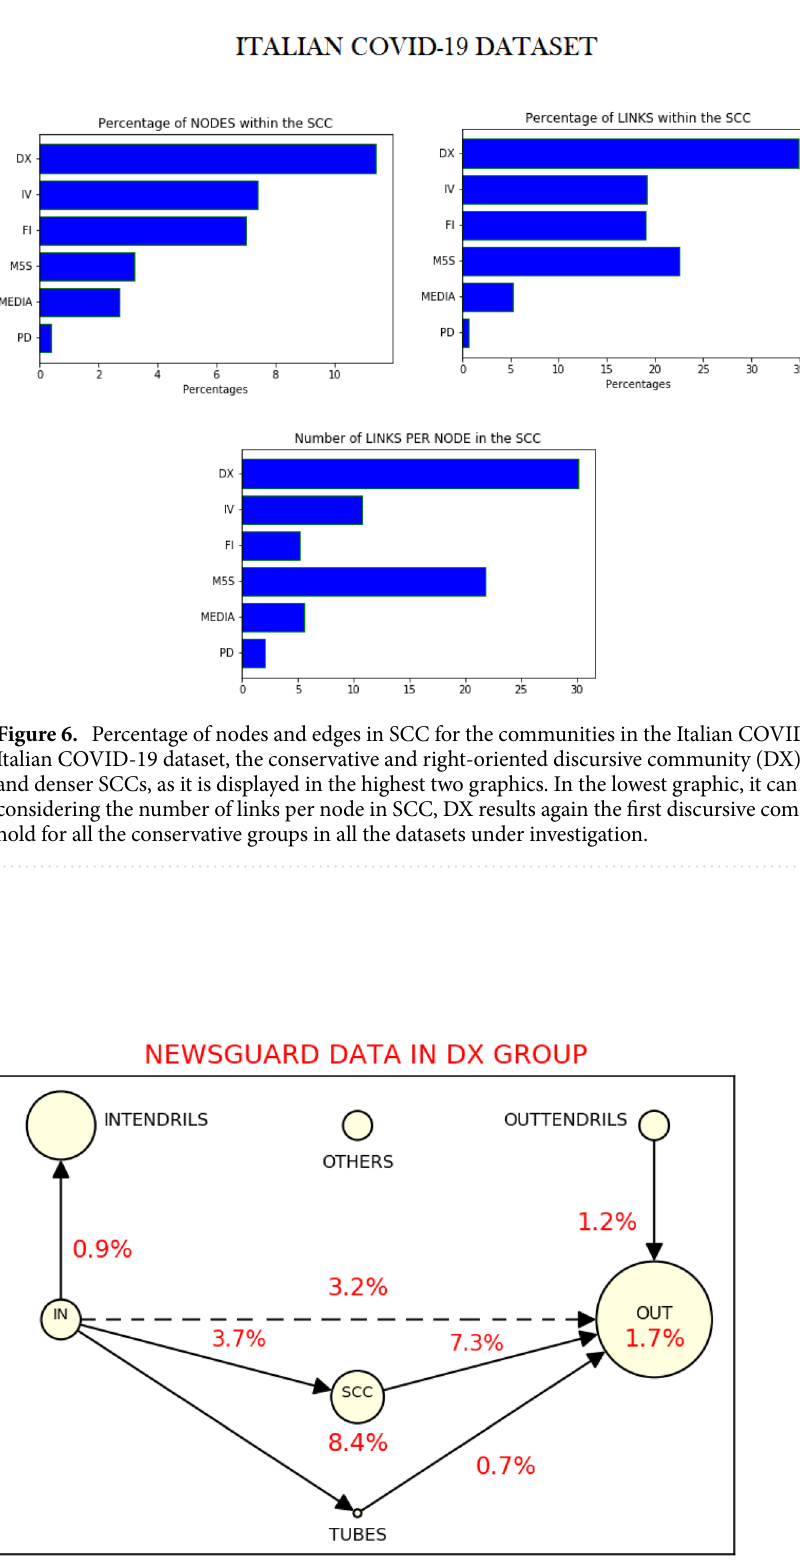
Figure 7. Bow-tie structure of the DX group and percentages of retweets containing URLs of untrustworthy webpages. The DX community in the Italian COVID-19 dataset presents the highest number of retweets containing a link to untrustworthy webpages. Most of them origin from SCC: 8.4% of the retweets in SCC and 7.3% of the retweets between SCC and OUT contain not reliable URLs. In the diagram, we also insert the link between IN and OUT (the dashed line), which, considering the definition of each sector, is not forbidden a